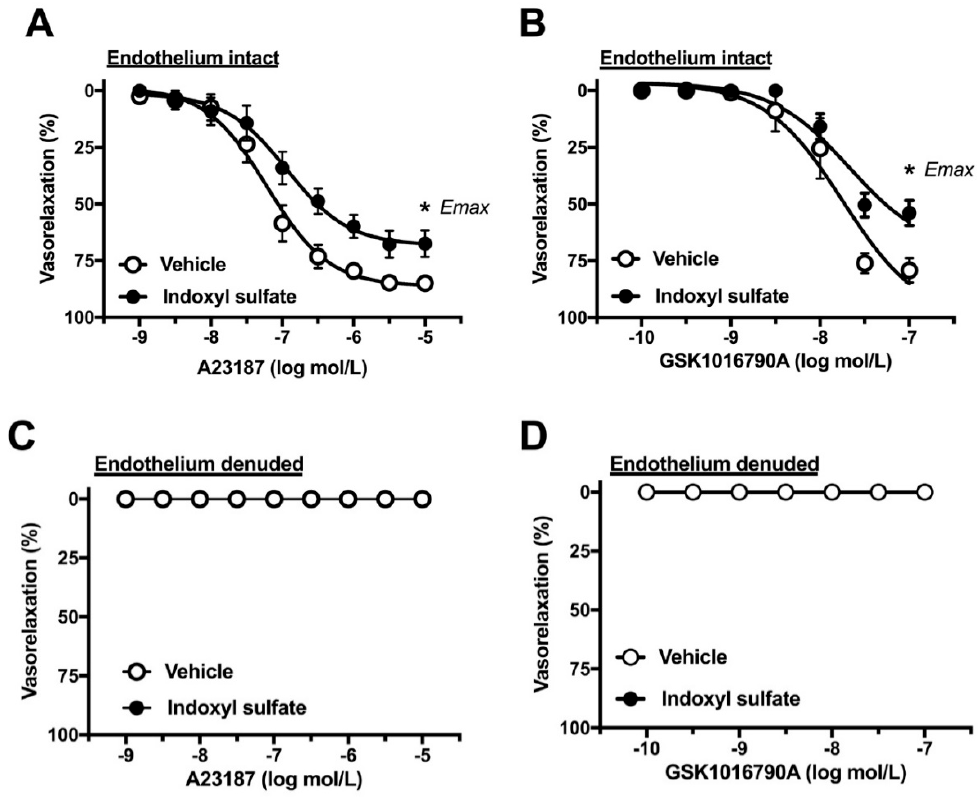
Figure 5. Concentration–response curves for A23187 ( A ) or GSK1016790A ( B )-induced vasorelaxations in endothelium-intact ( A , C ) or -denuded ( B , D ) aortas in the absence (vehicle) and presence of indoxyl sulfate (10 − 4 mol/L). The ordinate shows vasorelaxation as a percentage of PE-induced vasocontraction (0% being defined as the plateau level of precontraction). Data are presented as mean ± standard error of mean (SEM) values from eight ( A ) or six ( B – D ) experiments. * p < 0.05, vs. Vehicle; E max .